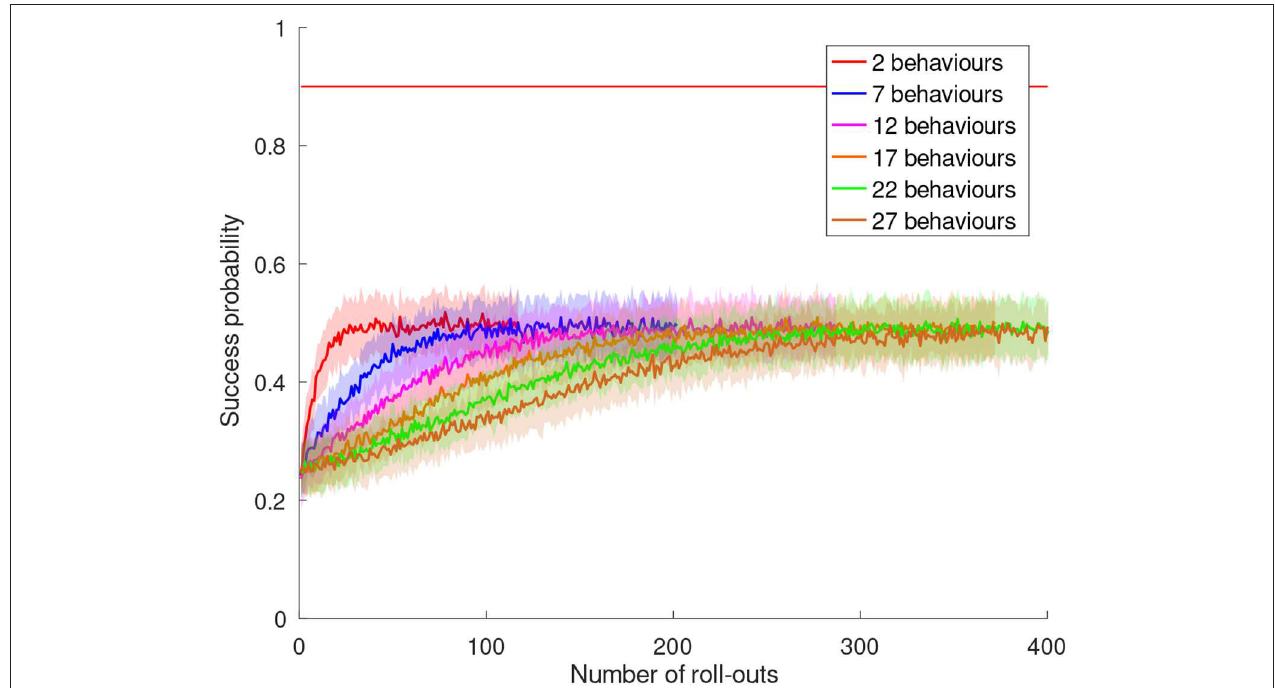
FIGURE 10 | Success rates without active learning and without behavior composition in a setting that requires behavior composition, i.e., not all preparatory behaviors required to solve the task are available. In this case, the void behavior and the behavior to transition to the neighboring perceptual state are available. This enables the agent to solve the task for two out of four perceptual